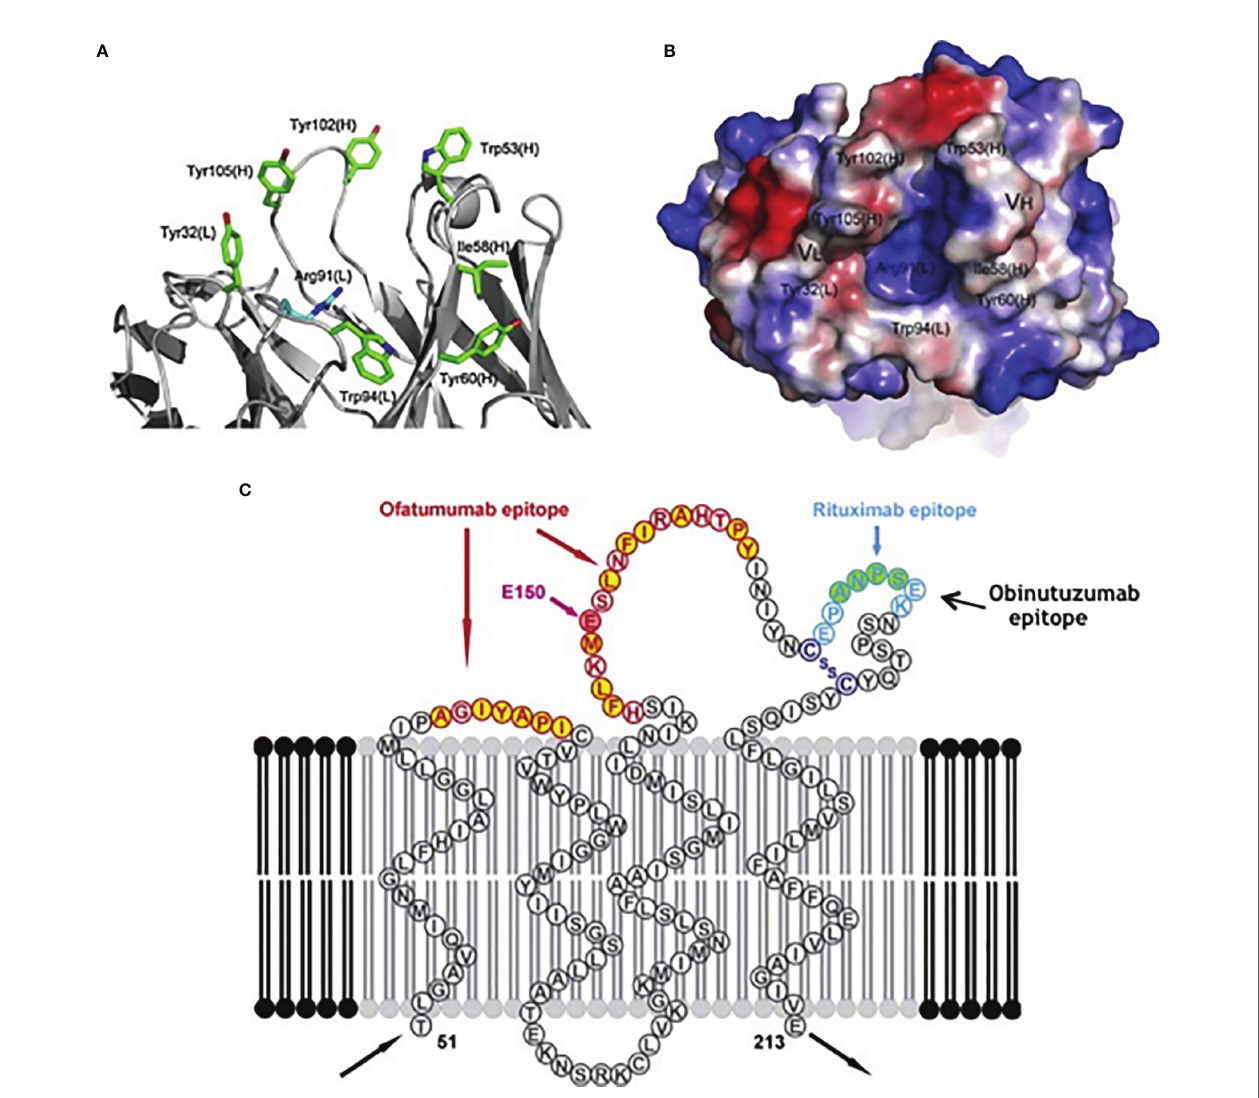
FIGURE 1 | Binding sites for speci fi c targets present in different anti-CD20 monoclonal antibodies: (A) details, (B) crystalized structure, (C)